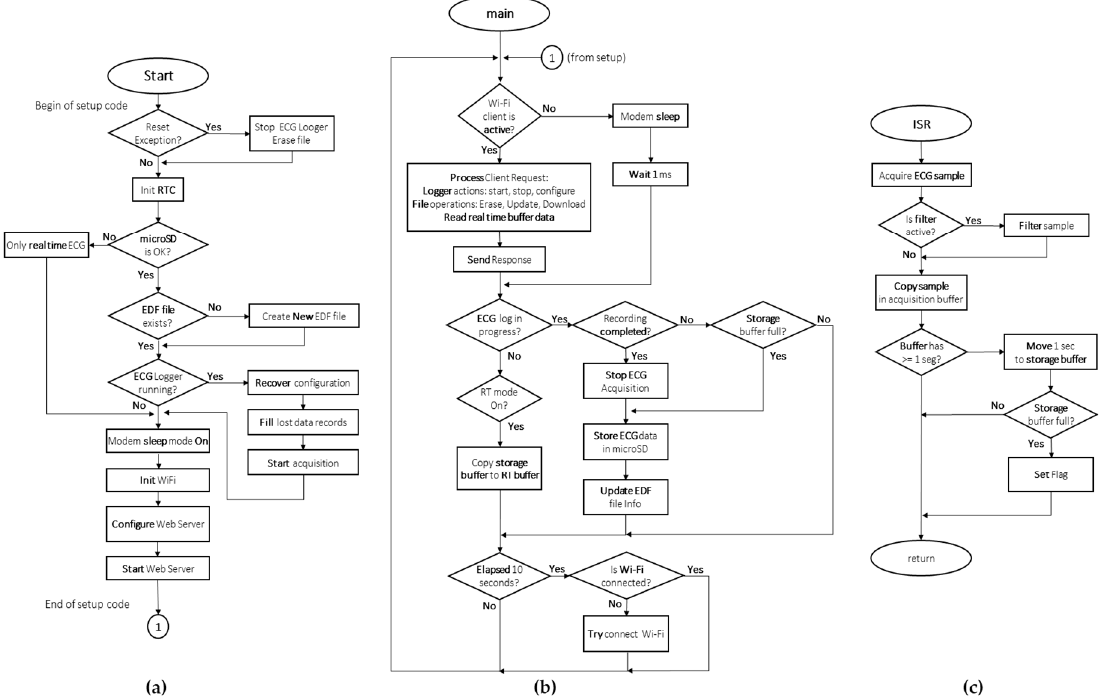
Figure 9. Firmware flow-chart: ( a ) start-up or setup sequence; ( b ) main program loop; ( c ) interrupt service routine